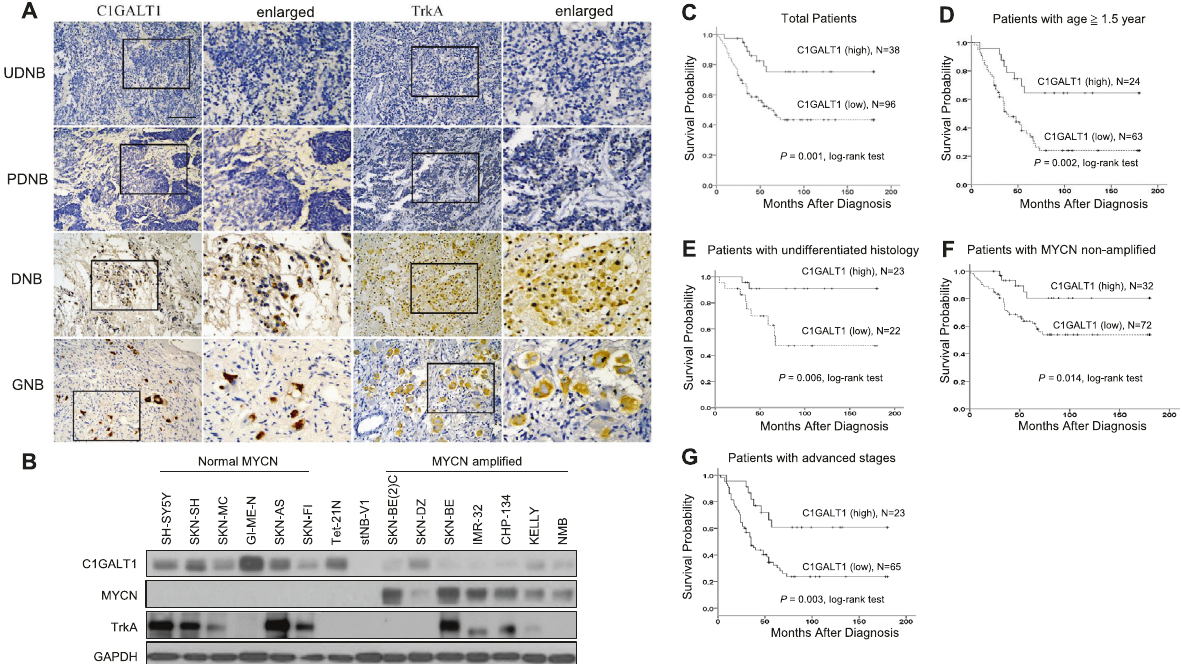
Fig. 1 C1GALT1 expression predicts better prognosis for patients with NB. A Representative images of IHC staining for C1GALT1 protein in NB tumors with indicated histological types. Brown colors represent positively stained cells. Tumors with more mature differentiation (GNB or DNB) exhibit higher expression levels of C1GALT1 protein in general. Inversely, UNB and NB tumors exhibit lower levels of C1GALT1 expression. Scale bars, 100 μ m. High magni fi ed images of the area are marked by the rectangle. B Immunoblotting analysis of C1GALT1, MYCN, and TrkA expression in various NB cell lines with MYCN ampli fi cation or non- ampli fi cation, using GAPDH as internal control. C Kaplan – Meier overall survival analysis according to the expression of C1GALT1 in 134 patients with NB ( p = 0.001, log-rank test). D – G Kaplan – Meier survival analysis according to the expression of C1GALT1 in patients with age ≧ 1.5 years ( p = 0.002, log-rank test), undifferentiated histology ( p = 0.006, log-rank test), MYCN non-ampli fi ed ( p = 0.014, log-rank test), advanced-stage disease ( p = 0.003, log-rank test),